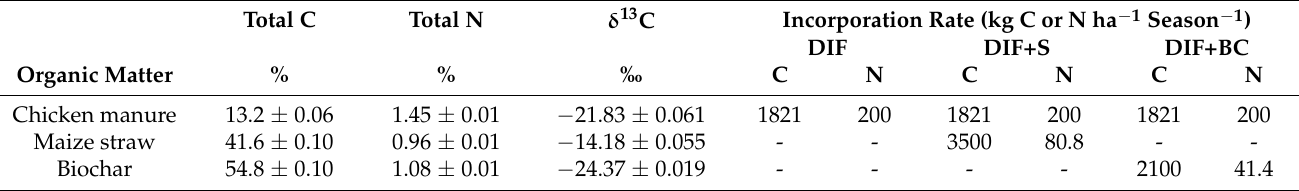
Table 2. Total C and N concentrations and δ 13 C signature of chicken manure, maize straw and biochar. In addition, seasonal rates of organic matter applications for the different treatments are